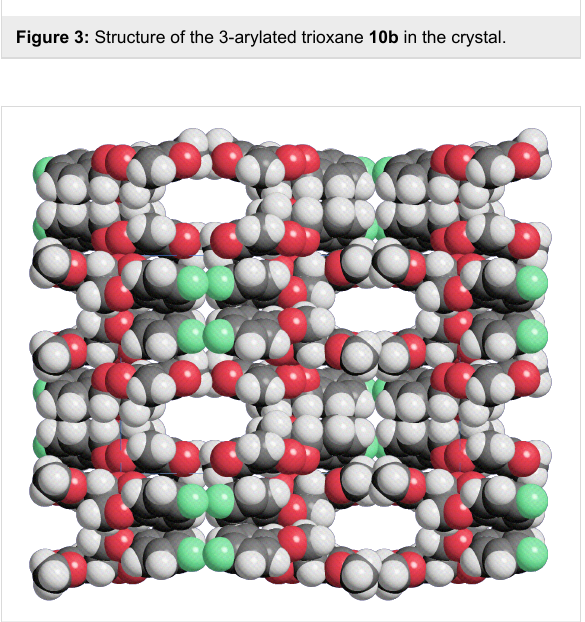
Figure 4: Structure of the p-bromophenyl derivative 10d in the crystal lattice (disordered water molecules in the cannels are not shown) viewed along the a